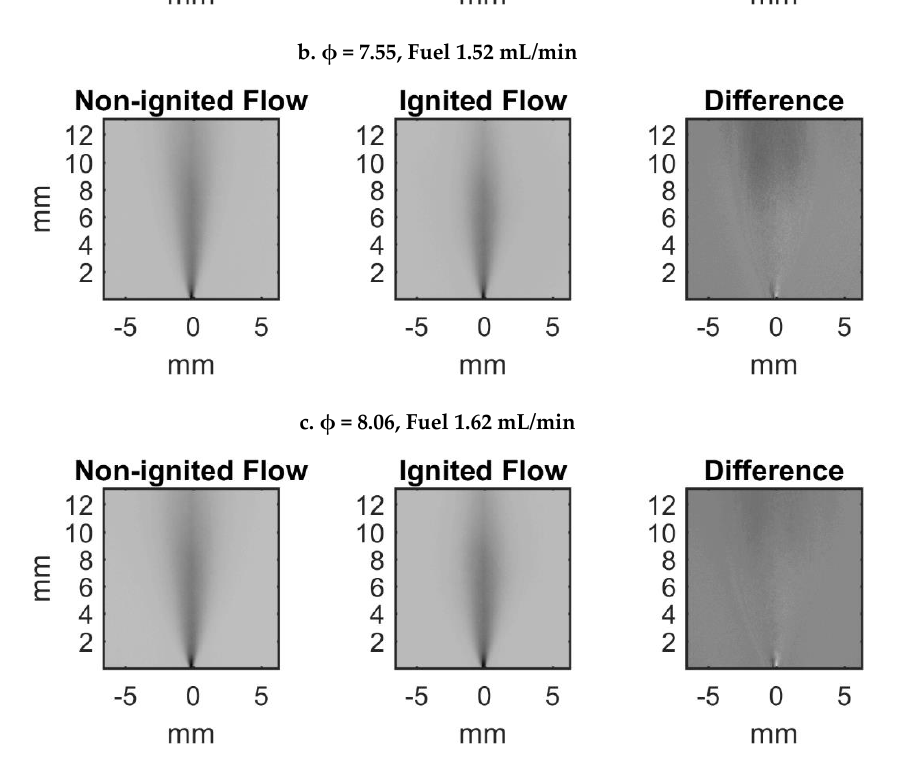
Figure 6. Shadowgraph images of Jet A spray at four equivalence ratios. Shadowgraphs are averaged from 100 sequential shots. The O 2 flow rate was fixed at 0.4 L/min.